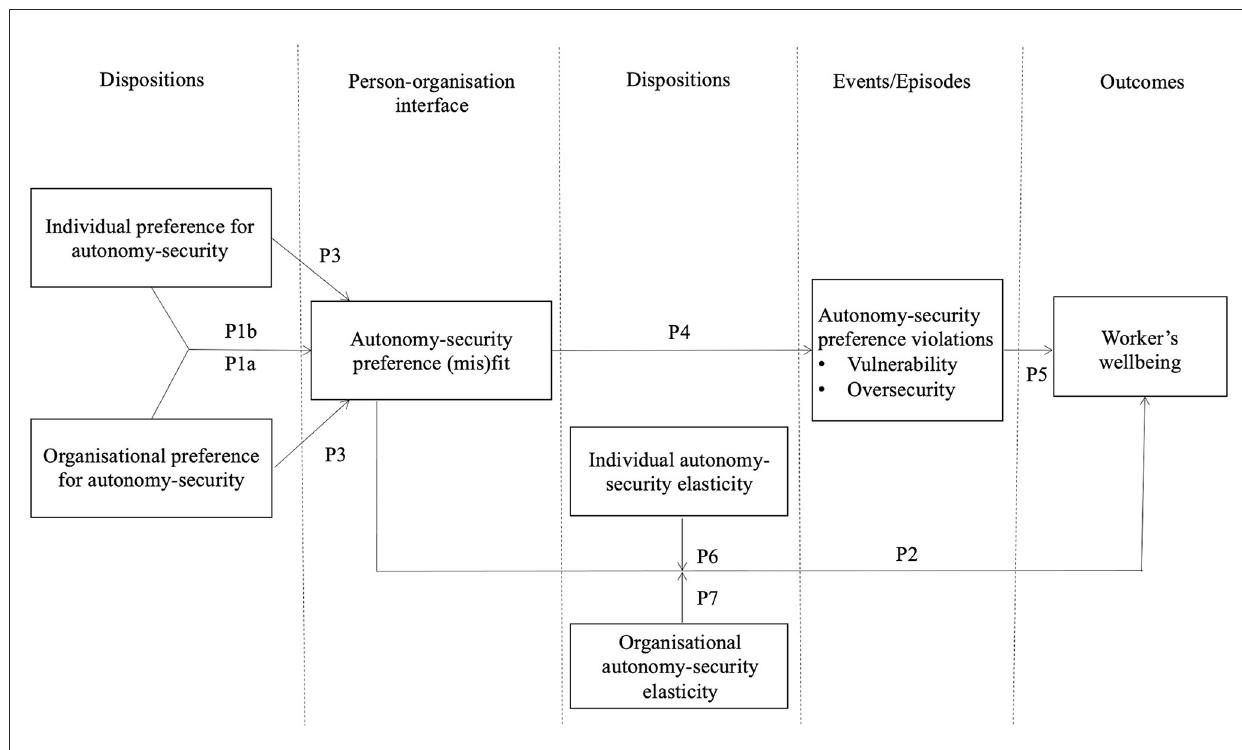
FIGURE2 A grounded theory of gig-worker